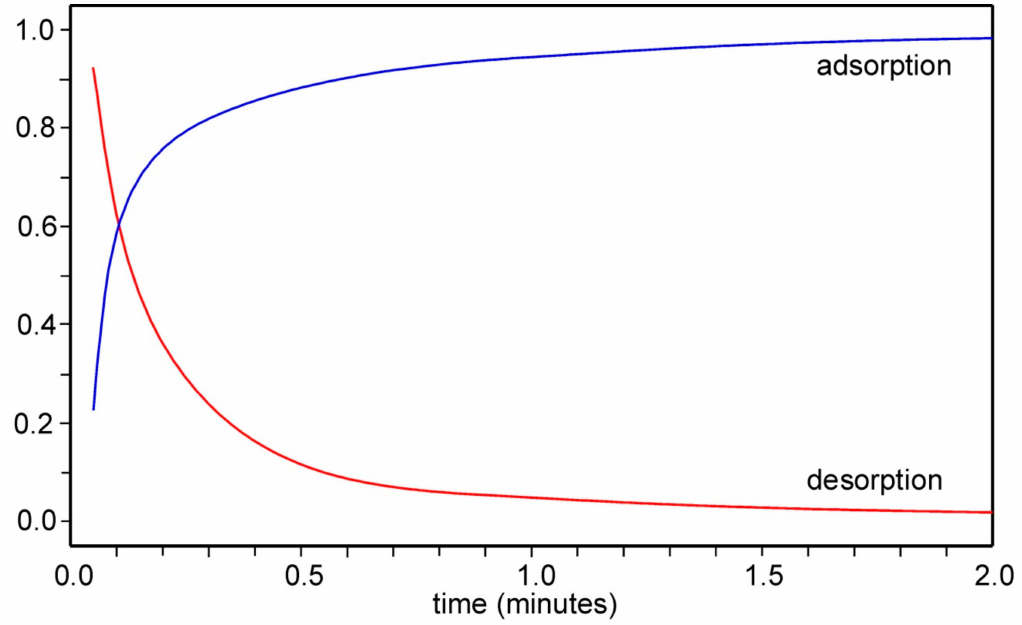
Figure 9. Curves showing normalised TGA adsorption and desorption steps of CO 2 on nominal Li 2 / 3 Cu[Fe(CN) 6 ] 2 / 3 at 21 ◦ C. The sample weight was ~16